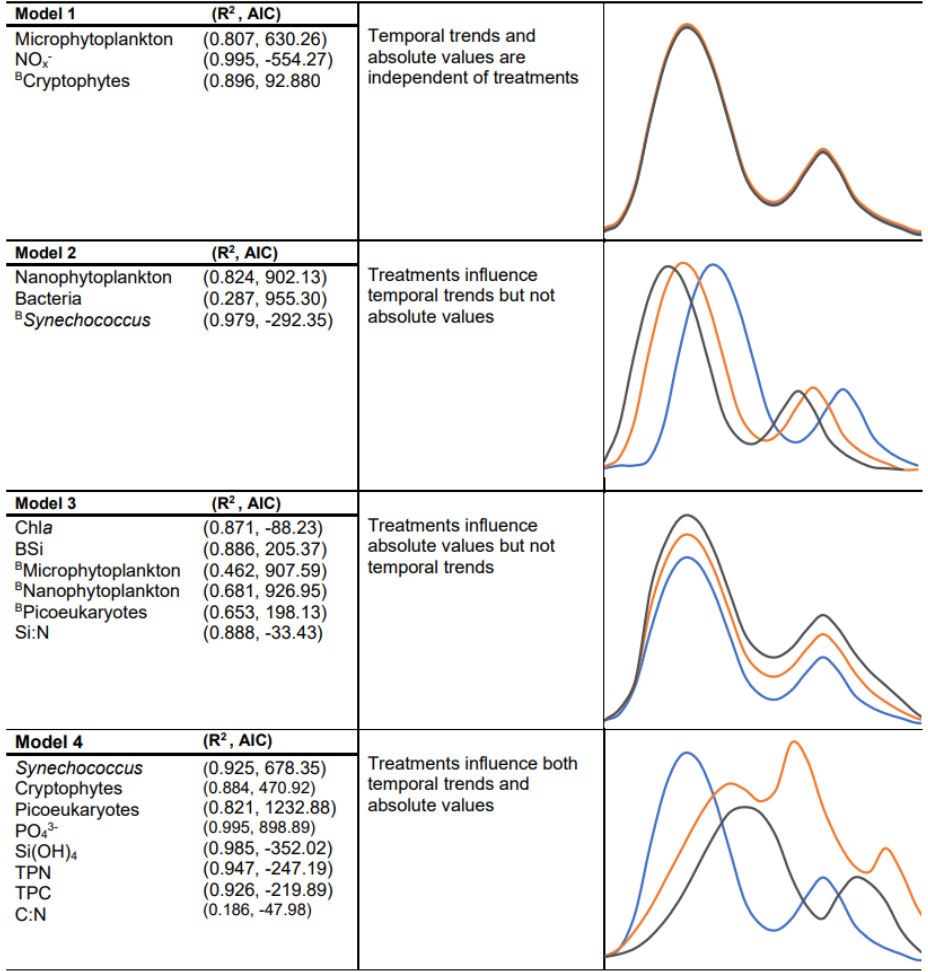
Figure 3. GAMM results (AIC and R 2 ) from the preferred model for each parameter with descriptive plots indicating the hypothesized smoothers for each model (phytoplankton biomass indicated with a B for each group). All smoothers had a p value < 0.05, indicating smoothers were significantly different from a straight line. For a given dependent variable, the model with the lowest AIC was considered to best represent the temporal trends during the experiment and is present in the figure